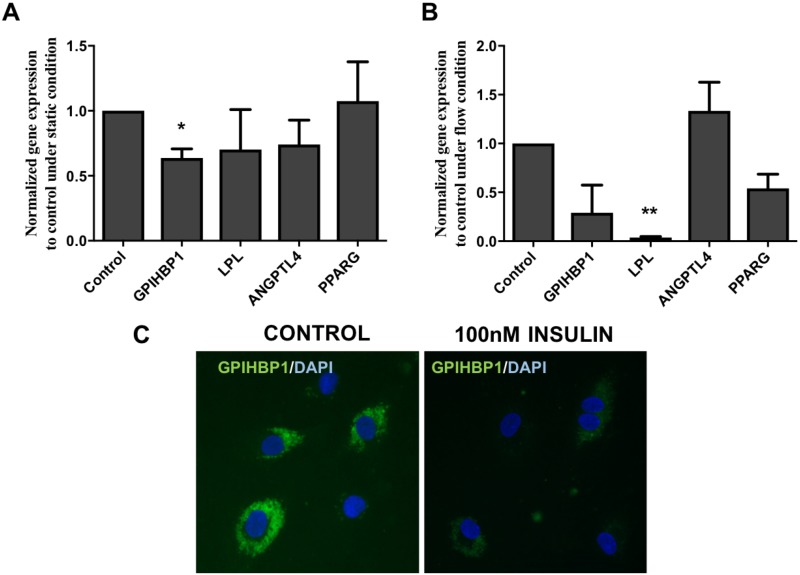
Effect of insulin on GPIHBP1 mRNA and protein expression in HMVEC under static and flow conditions.HMVECs (p4-p5) were cultured with or without 100nM insulin for 24 hours under static (A) or laminar flow conditions (B) as described. Gene expressions of GPIHBP1, LPL, ANGPTL4 and PPARG were analysed in HMVEC under static (Fig 1A) and under flow condition (Fig 1B) were measured. Data are from 4 independent experiments and presented as mean ± SD. Representative immunofluorescence image of HMVECs stained for GPIHBP1 protein under static condition. Differences were analysed using Mann-Whitney nonparametric test. *P<0.05 and **P<0.01.